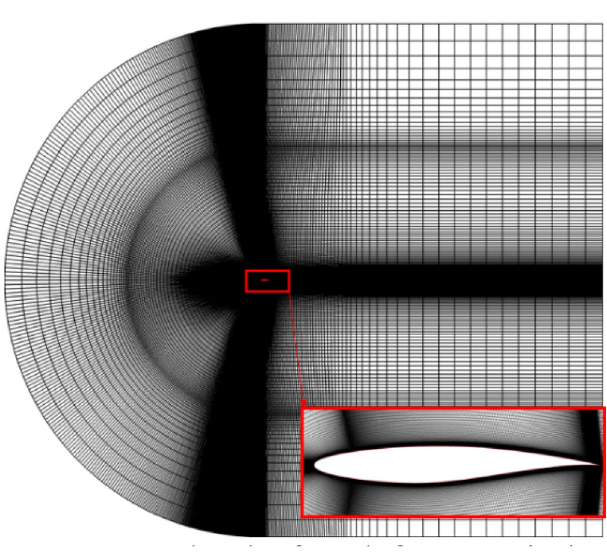
Figure 14. Sketch of mesh for numerical calculation.